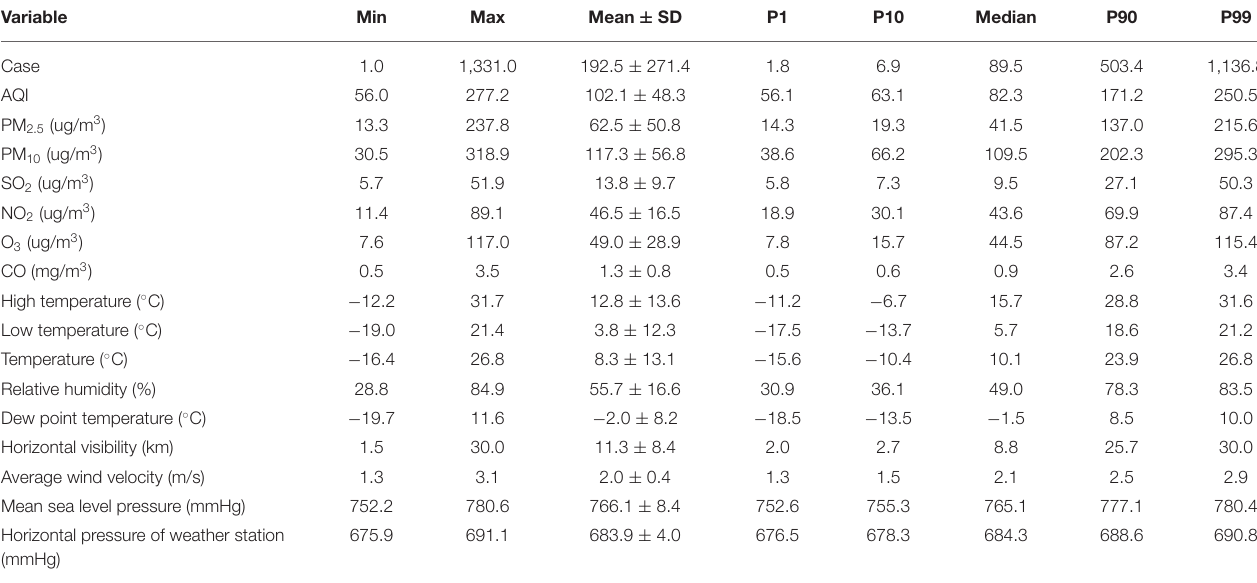
TABLE 1 | Description of HFMD cases and meteorological and atmospheric pollution factors in Urumqi from 2014 to